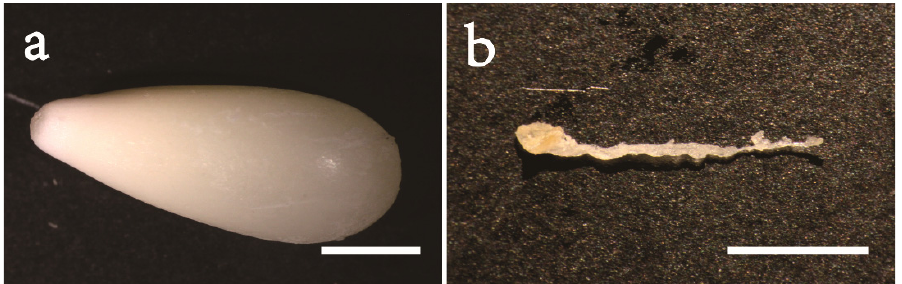
Figure 1. MG and ZE explants of Korean pine. ( a ) MG explants. Scale = 0.5 cm. ( b ) ZE explants. Scale = 0.5 cm.